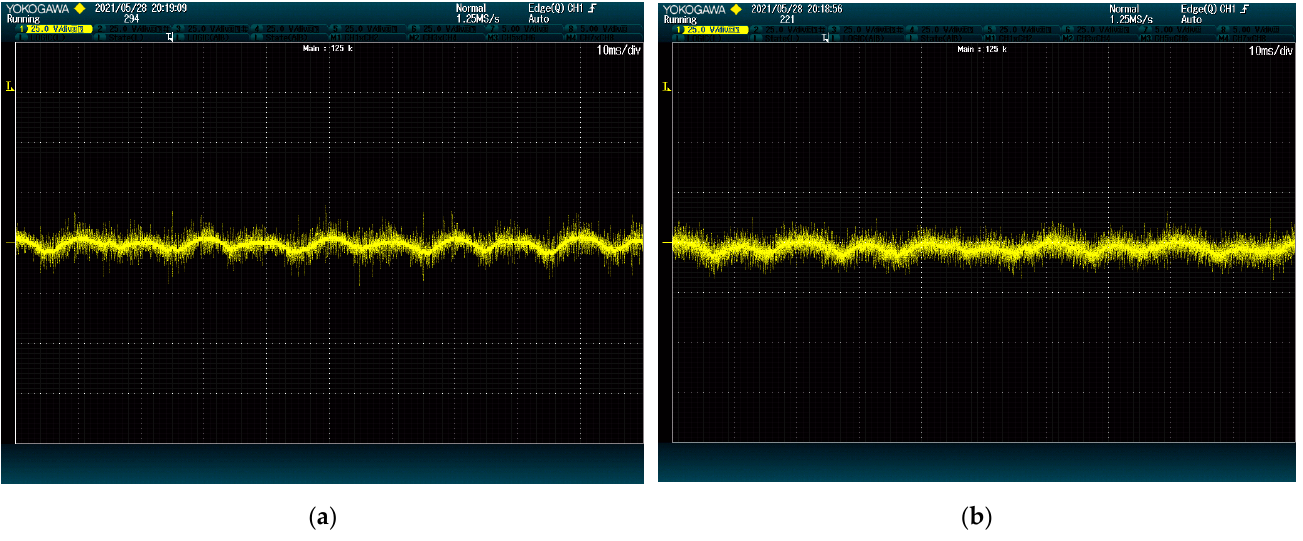
Figure 5. DC-Link voltage ripple: ( a ) proposed method; ( b ) state-of-the-art alternative. The plots show voltage (25 V/div) vs. time (10 ms/div).